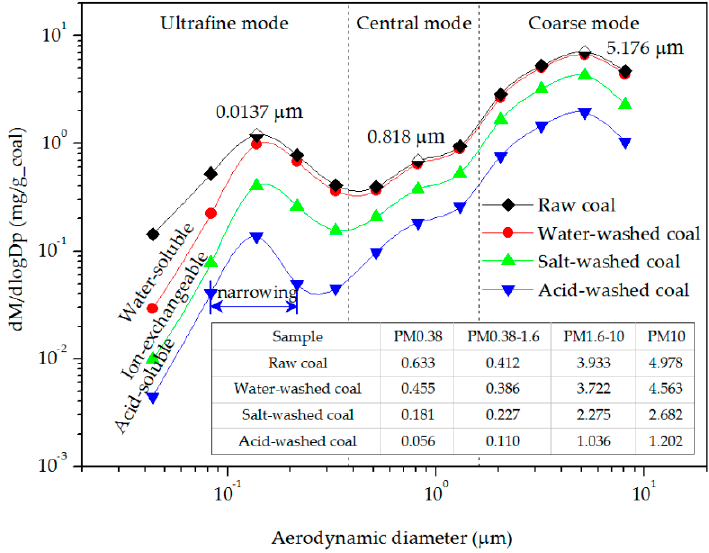
Figure 3. Mass concentration distributions and yields of PM from the combustion of the coal samples.